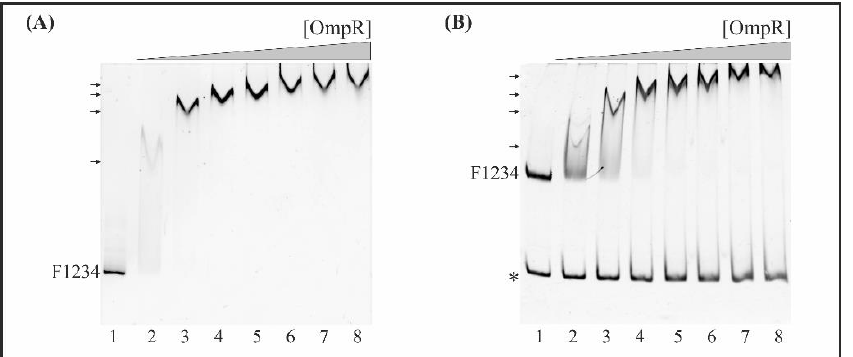
Figure 6. EMSA of the interaction between OmpR-His 6 with the F1234 DNA fragment encompassing the whole fur regulatory region including four putative OmpR-binding sites. ( A ) Quantitative EMSA. The 445-bp fur promoter fragment F1234 was incubated without protein (lane 1) or with increasing amounts of purified OmpR: 0.65 (lane 2), 1.3 (lane 3), 1.95 (lane 4), 2.6 (lane 5), 3.25 (lane 6), 3.9 (lane 7), 4.55 µM (lane 8). ( B ) Competitive EMSA. Mixtures of the 445-bp fur promoter fragment F1234 and a 304-bp fragment of 16S rDNA (*) were incubated with increasing amounts of purified OmpR as in ( A ). The OmpR/DNA complexes were resolved on a native polyacrylamide gel and detected by SYBR Green staining. Shifted bands containing the fur fragment F1234 are marked by arrows.